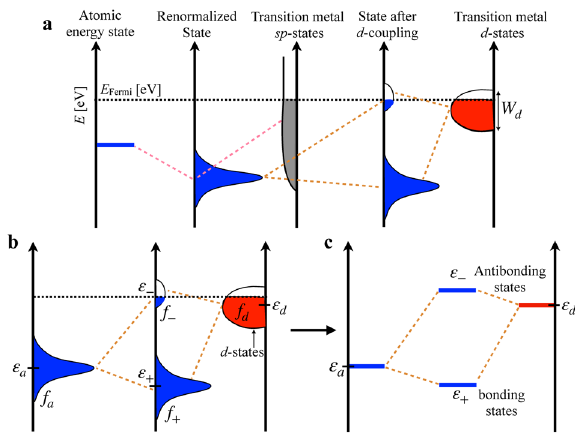
Fig. 1 Interaction between an adsorbate and transition metal surface states. a Schematic diagram showing the change in the electronic states of the adsorbate upon interaction with the delocalized sp -states and localized d -states on the metal surface 6 . Upon interaction with the metal sp -states, the sharp atomic states of the gas phase are broadened into resonances and shifted down. b , c Subsequent interaction of these renormalized states with the localized d -states gives rise to a splitting into bonding ( ε + ) and antibonding ( ε − ) states below and above the initial adsorbate and surface d